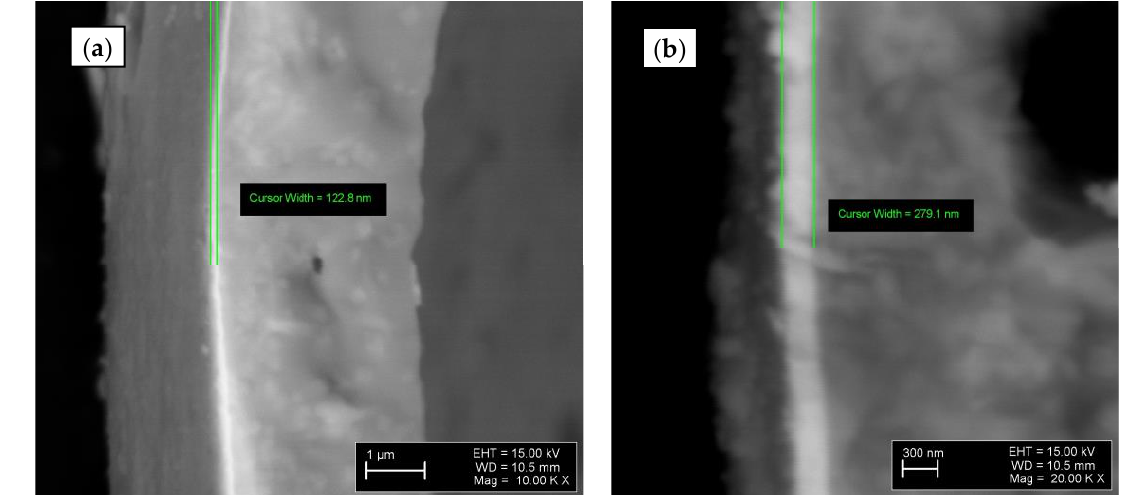
Figure 8. SEM micrographs of the Ti@CS ( a ) and Ti-TiN@CS ( b ).